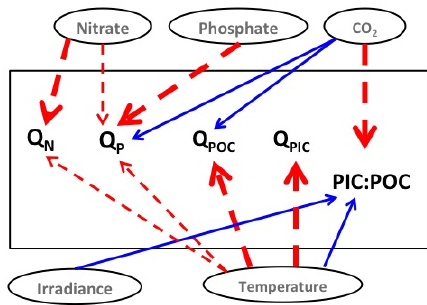
Figure 7. Conceptual figure of the specific effects of each the five environmental drivers, under the projected future conditions (year 2100), on the elemental composition of Emiliania huxleyi . Q repre- sents the cellular quota of each element of Emiliania huxleyi . The box denotes the E. huxleyi cell. Solid blue arrows indicate positive effects of the future environmental changes, and dashed red arrows indicate negative effects of the future environmental changes. Ar- rows in bold indicate the environmental drivers that play the most important role regulating the connected physiological metrics under the predicted environmental conditions for the year